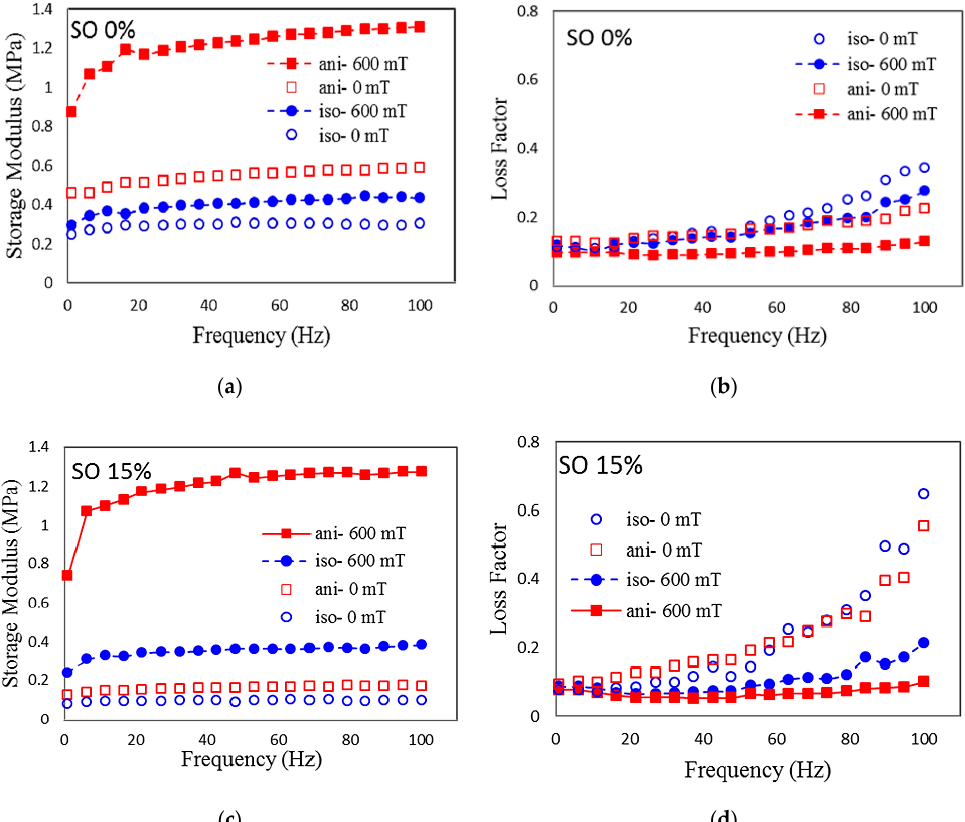
Figure 7. Storage modulus and loss factor of MRE with ( a , b ) 0 wt% of SO and ( c , d ) 15 wt% of SO as a function of excitation frequency at various magnetic fields.